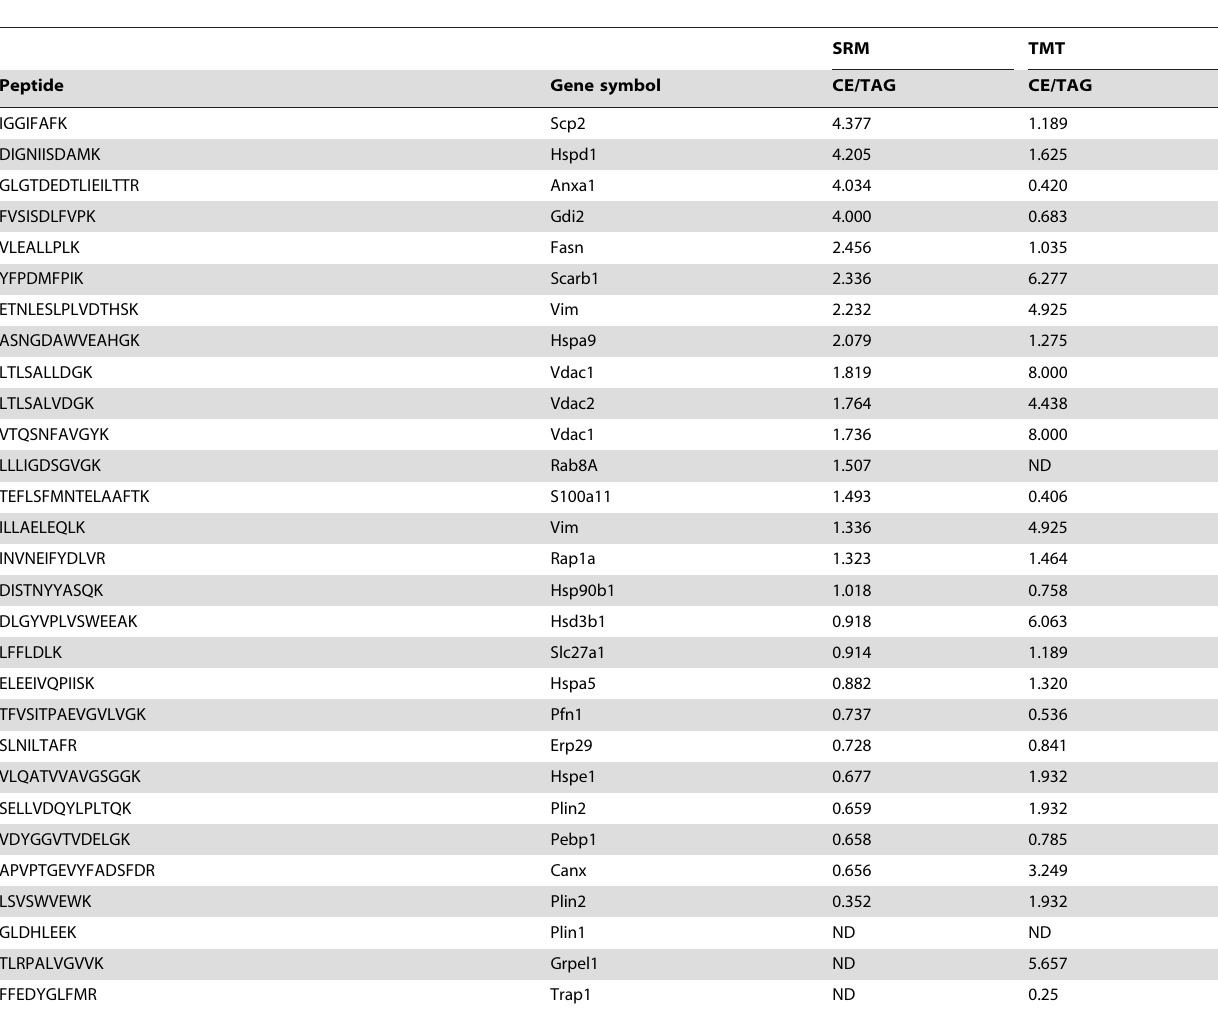
Table 3. Comparison of select LD-associated proteins detected by SRM and TMT MS